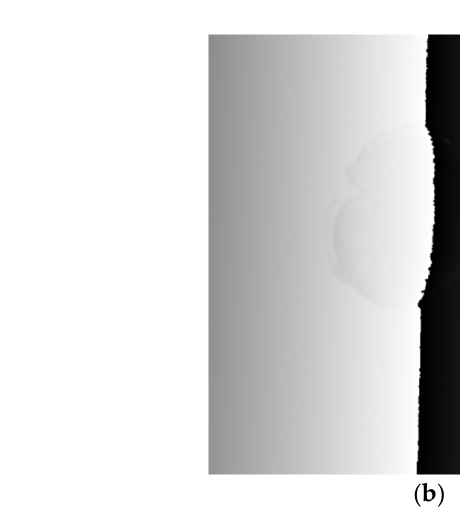
Figure 4. The result of the SIFT algorithm.